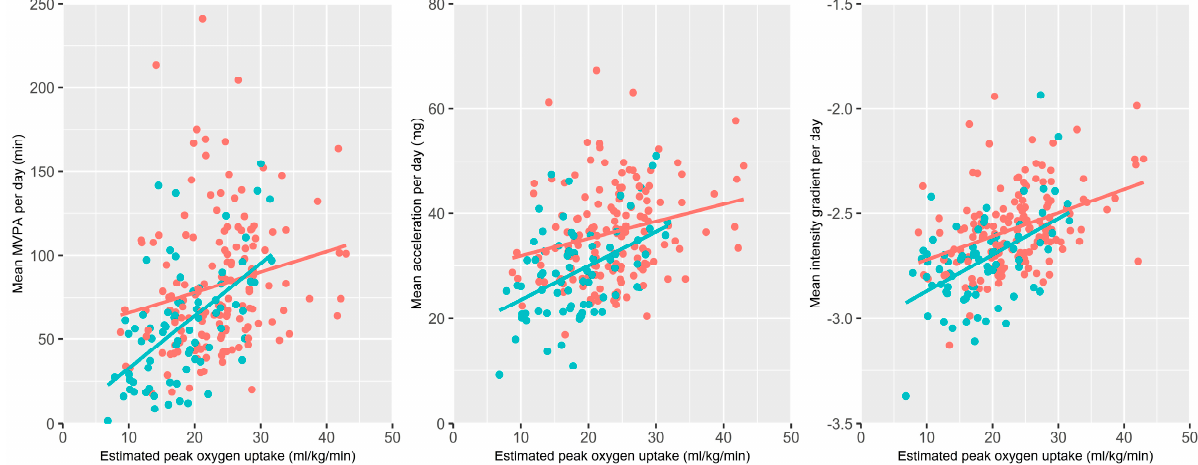
Figure 2. Scatter plots displaying the relationship between estimated peak oxygen uptake (VO 2peak ) against moderate to vigorous physical activity (MVPA), average acceleration and intensity gradient. Colouring indicates COPD diagnoses (blue = COPD & red = control) and lines represents linear regression lines.